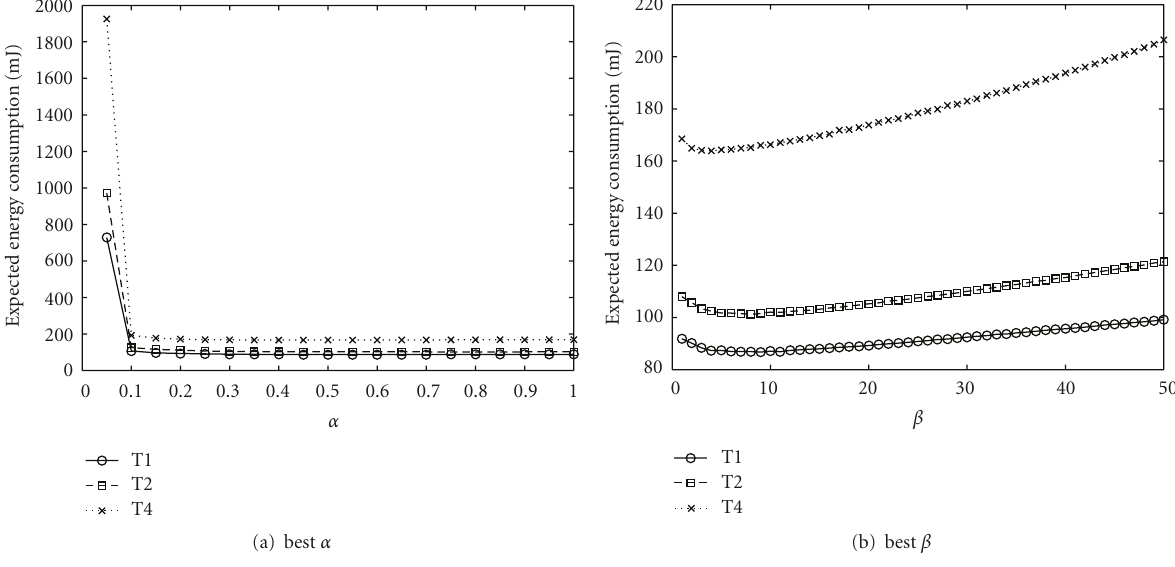
Figure 14: The best α and β for IEEE 802.15.4 energy consumption, 20Bytes.